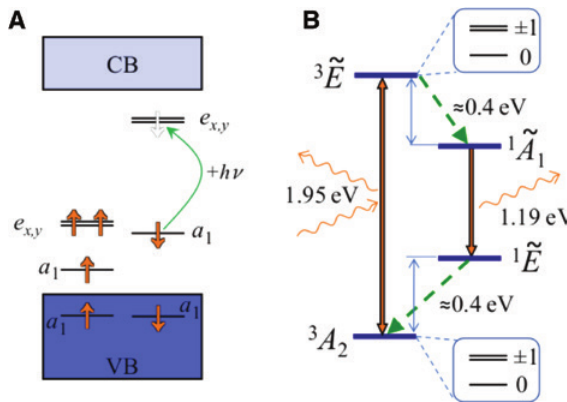
Figure 5: (A) Single-particle scheme of the electronic structure of the NV center. The spinpolarization between spin-up and spin-down electrons in the KS DFT results in different levels for spin-up and spin-down orbitals. VB and CB refer to valence band and conduction band, respectively. The fundamental bandgap of diamond is 5.4 eV. Green arrow represents the optical transition within a single- particle scheme. (B) Level structure of the NV center with taking the geometry relaxation in the corresponding electronic states into account. The character of the wave functions are depicted. Tilde labels the vibronic or polaronic nature of the state, which is particularly strong for the 3 E and 1 E